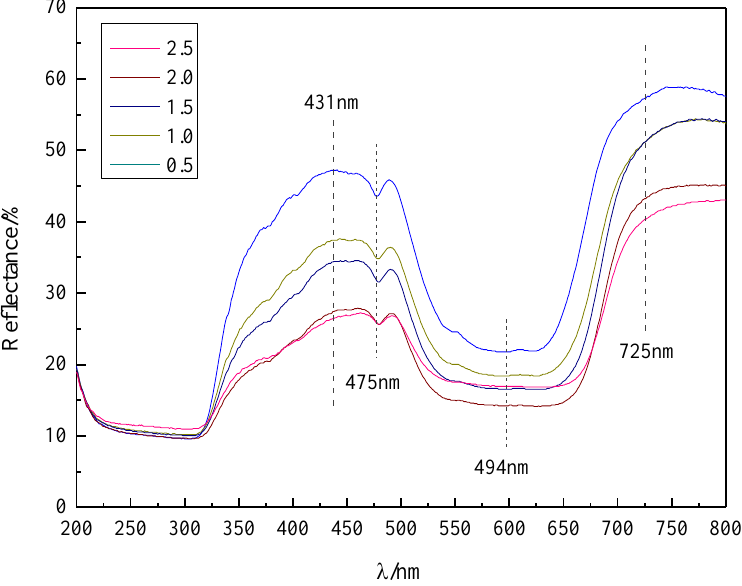
Figure 3. UV-Vis diffuse reflection of Mg-based lanthanum hexaaluminate samples prepared at 1450 °C under different Co contents.